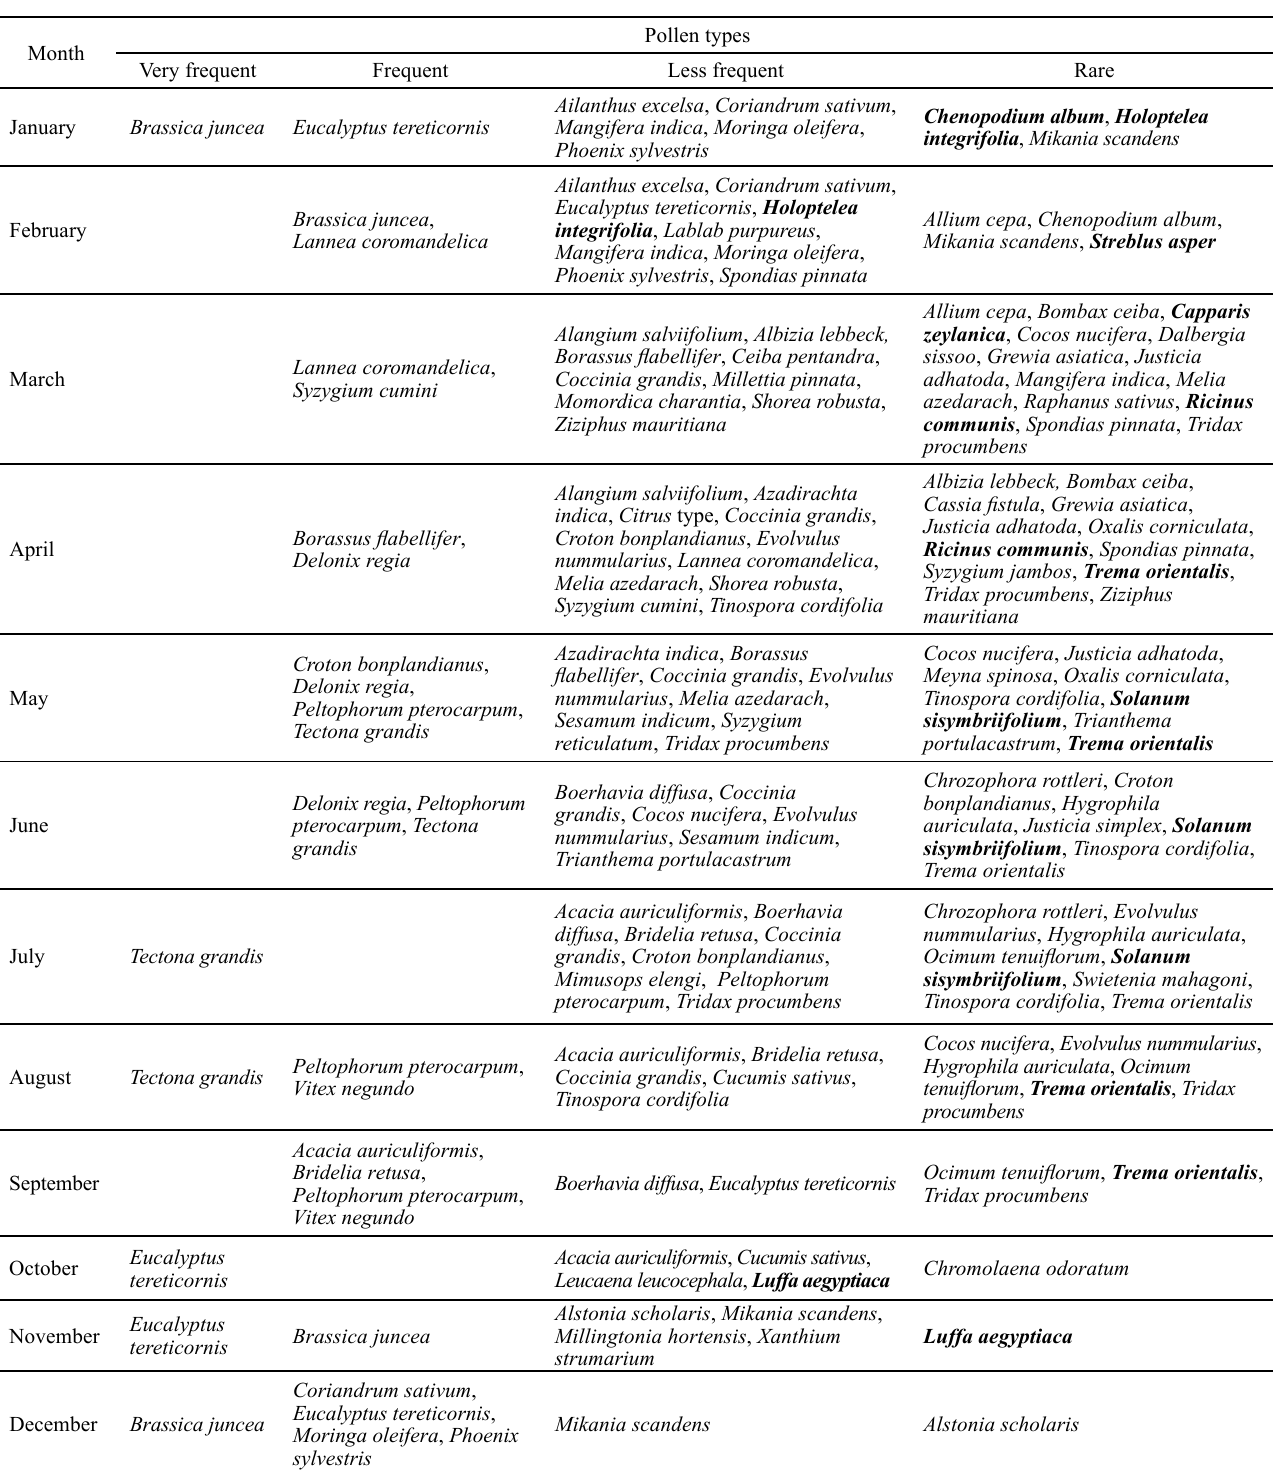
Table 3. Month-wise pollen types obtained from bee’s body surface pollen analysis in Garhbeta, West